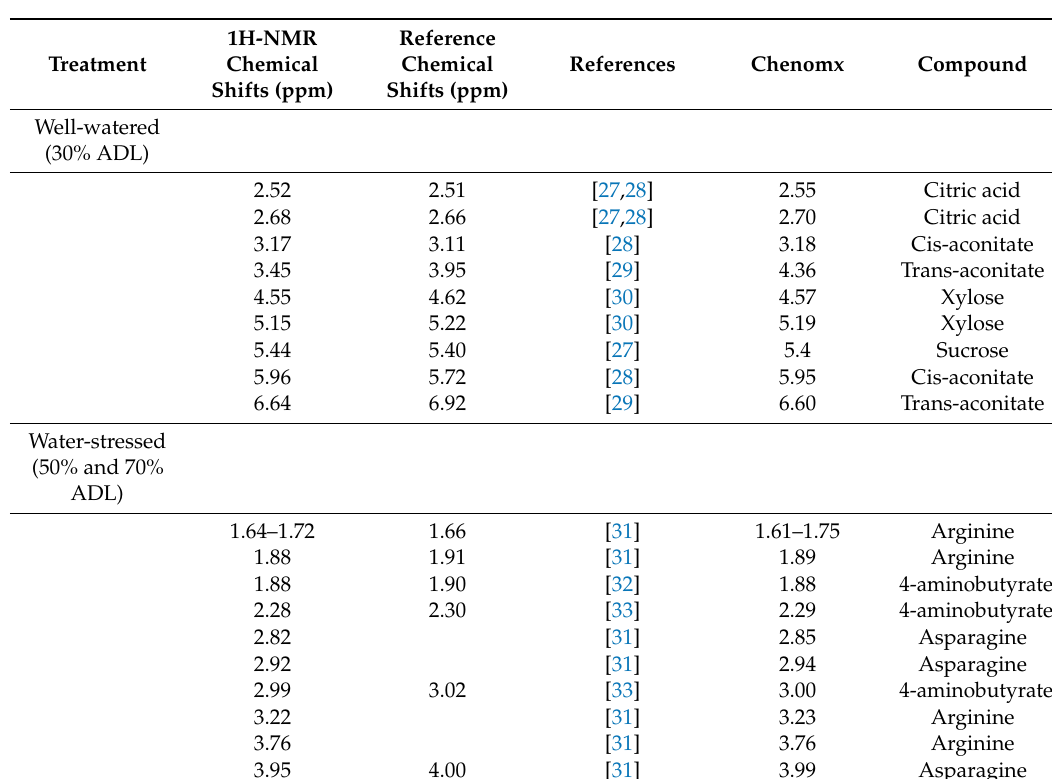
Table 2. Specific NMR regions and annotated compounds, which contributed to the separation of the well-watered treatment (30% ADL) from the water-stressed treatments (50% and 70% ADL) as related to the contribution